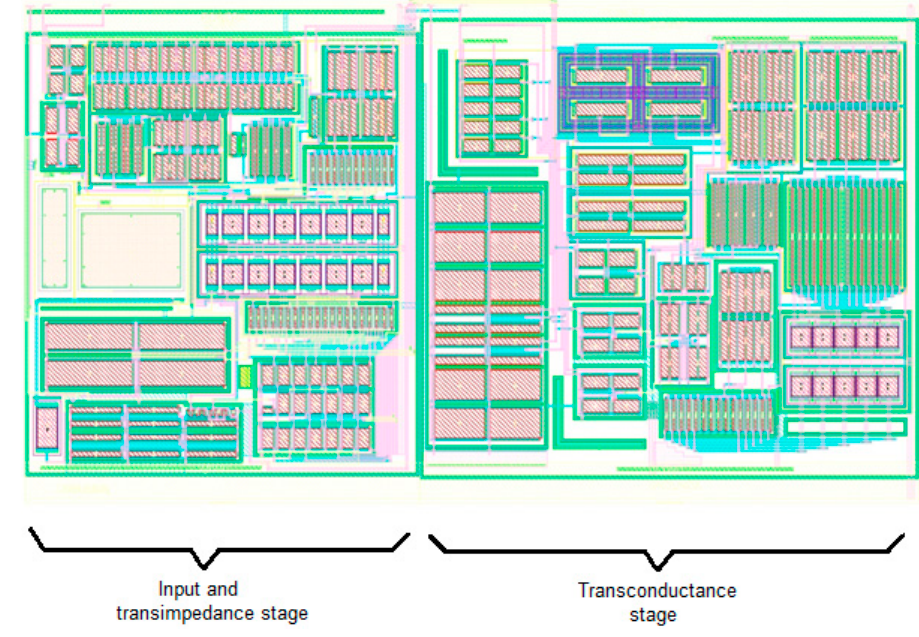
Figure 16. Layout of the presented amplifier.